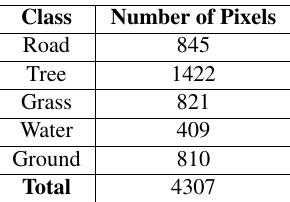
Table 3. Distribution of samples collected from five areas for five different classes.